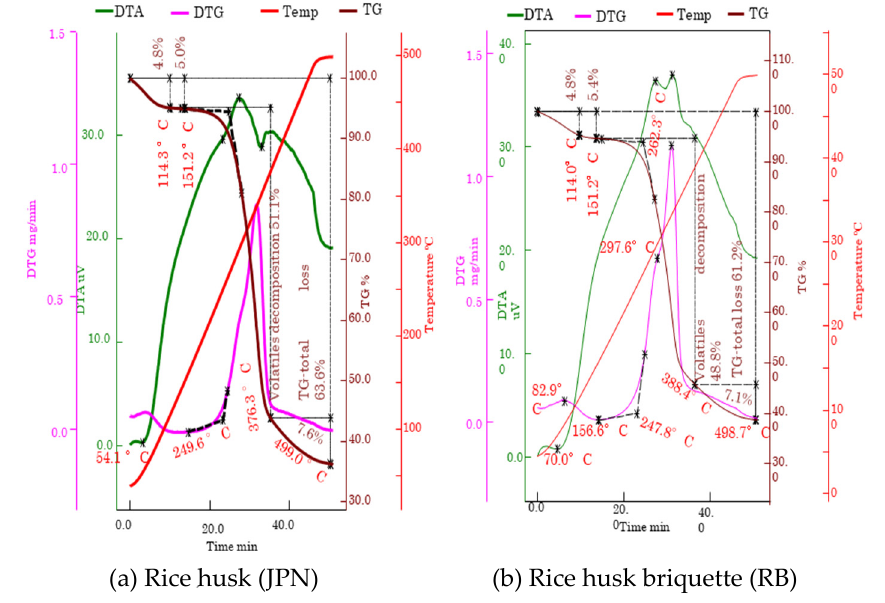
Figure 3. Thermogravimetric analysis of ( a ) rice husk and ( b ) rice husk briquette.